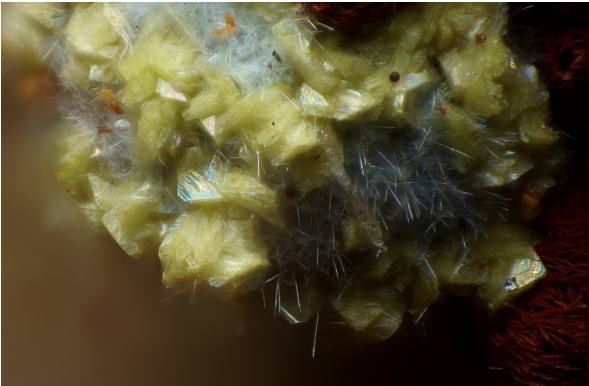
Figure 1. Graulichite-(La), as yellow rhombohedral crystals with thin needles of agardite-(La). Field of view: 0.5mm. Collection Georges Favreau, photo Pierre